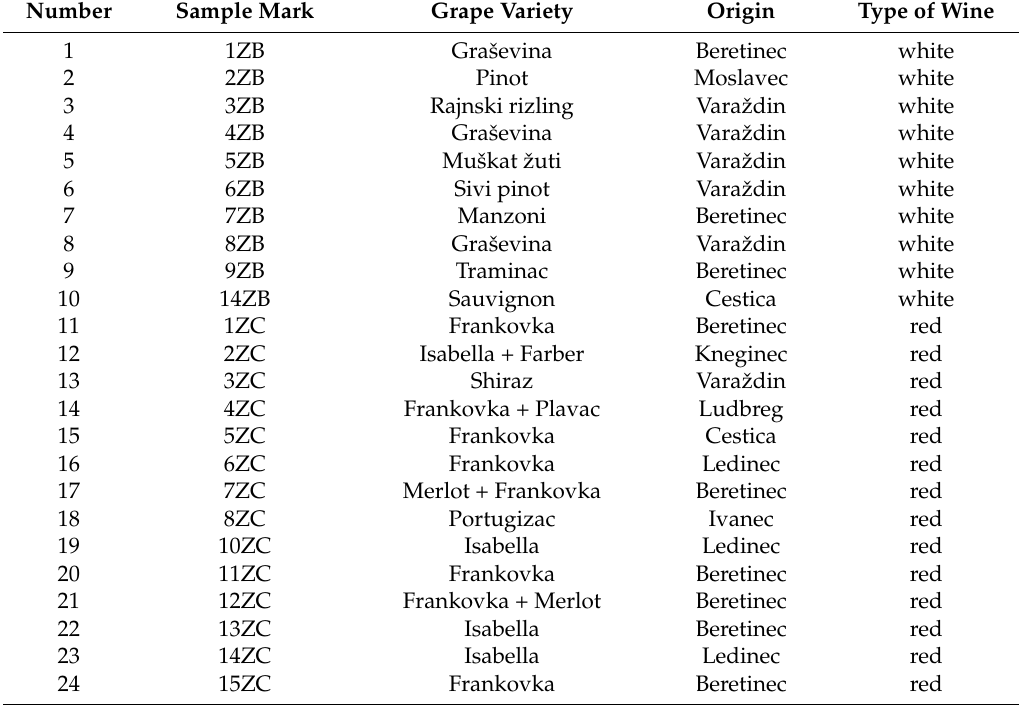
Table 2. The investigated red and white wine samples from Croatian continental wine region of Hrvatsko zagorje.